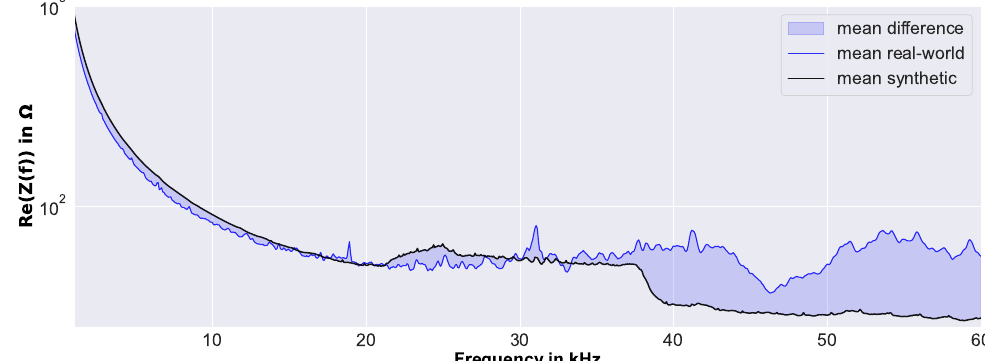
Figure 12. Difference between mean EMI spectra of all pristine real-world EMI spectra and mean EMI spectra of all pristine synthetic EMI spectra used to calibrate single real-world EMI spectra before